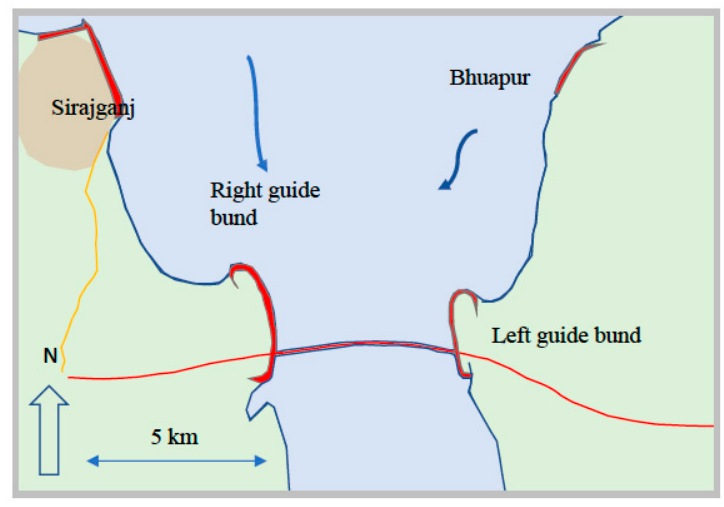
Figure 4. Sketch of the training works of the Jamuna Bridge. Legend: red = highway and river training works, yellow = secondary road, blue = boundary of the braiding belt, green = land, brown = Sirajganj town.